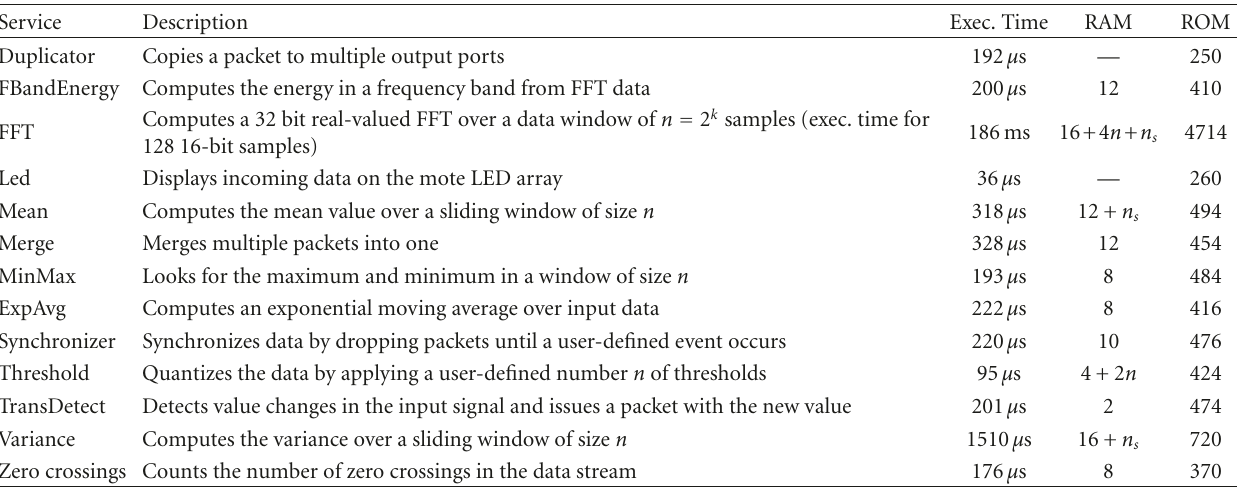
Table 3: Titan service set and execution time T i on a Tmote Sky. RAM indicates the number of dynamic memory bytes allocated, and ROM is the bytes of code memory used. The delay has been computed for a packet of 22 bytes data. n s gives memory bytes needed to store n in the data type used, for example, for 16 bit values n s = 2 n .